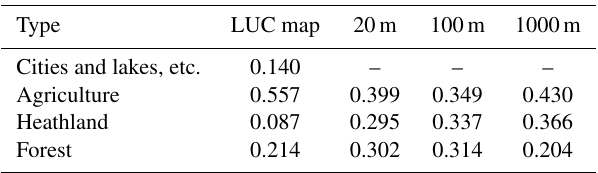
Table 1. Fraction of LUC types in the LUC map and in the clusters at spatial resolutions of 20, 100 and